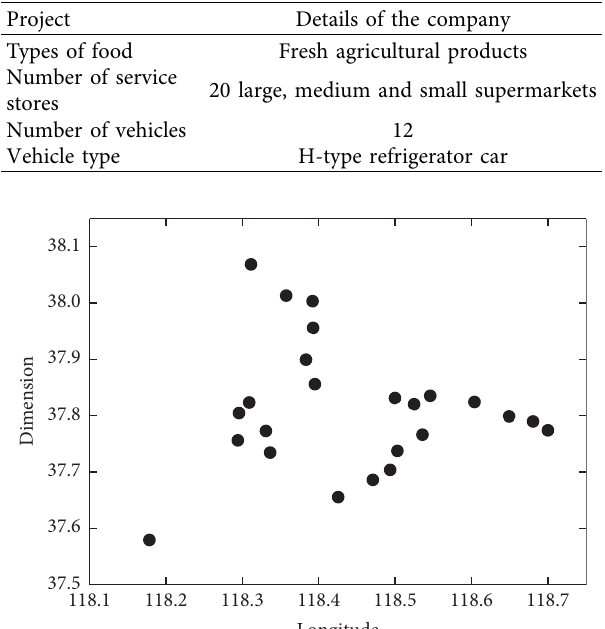
Table 1: Distribution situation of U company.